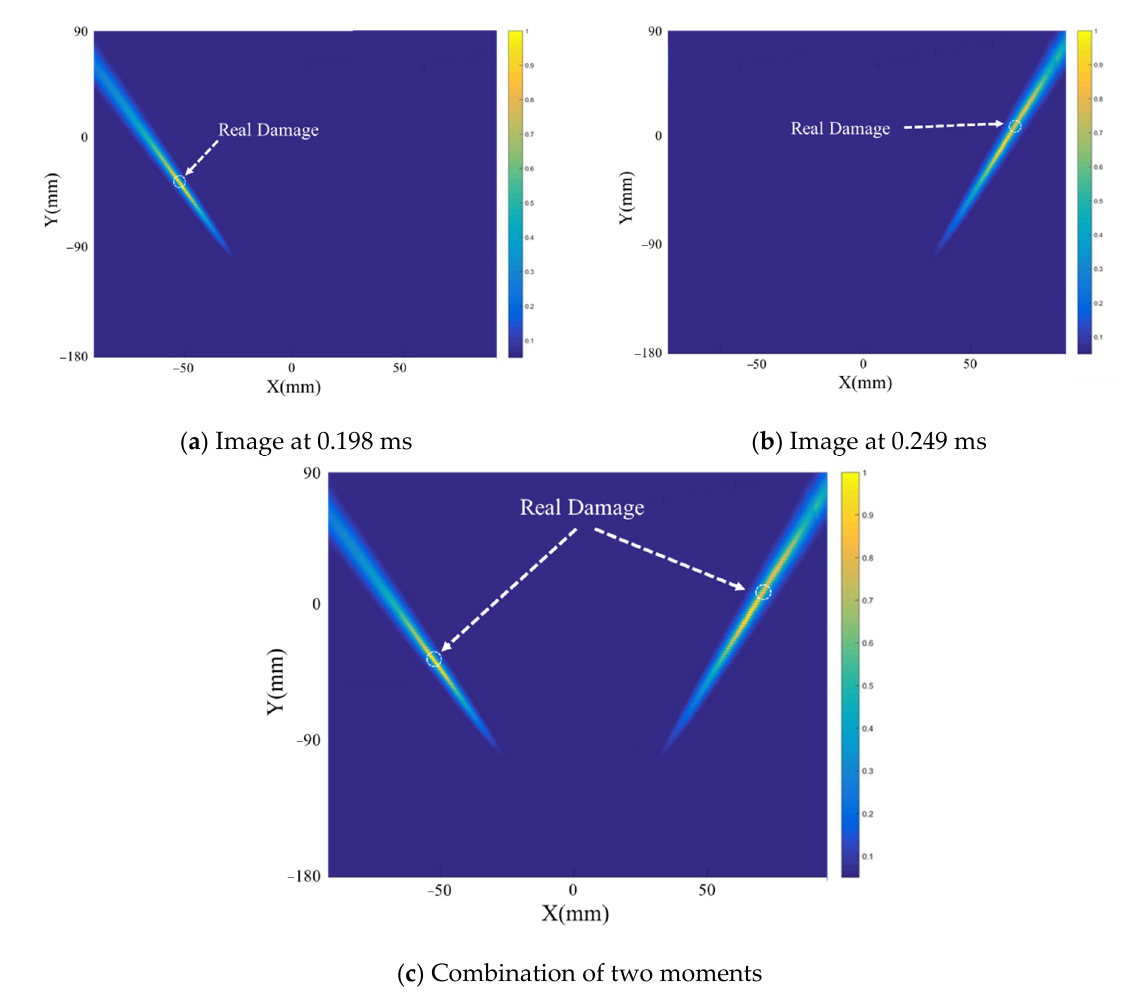
Figure 24. Damage image of two ‐ damage case in the experiment.